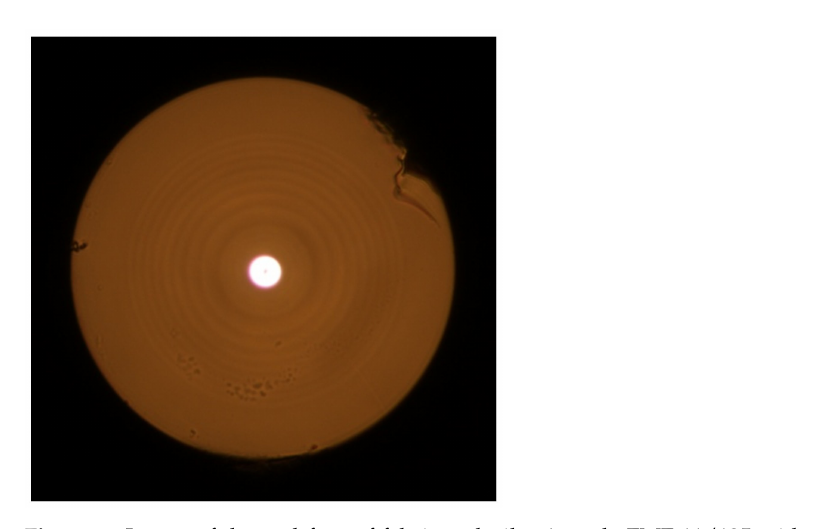
Figure 2. Image of the end-face of fabricated pilot 4-mode FMF 11/125 with numerical aperture NA = 0.22 (high-resolution optical microscope Nikon Eclipse N-U).